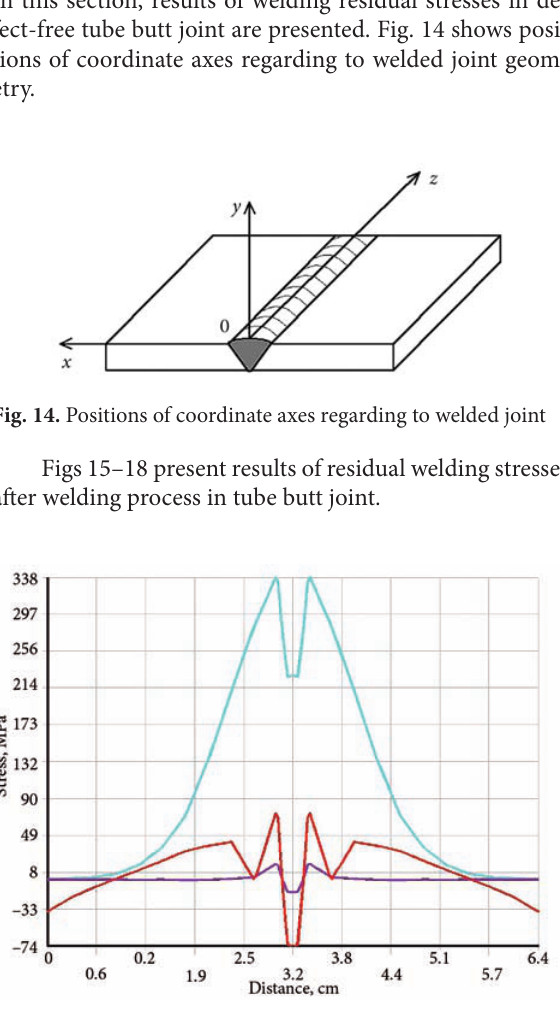
Fig. 12. Temperature distribution fields after 120 s from welding simulation has started